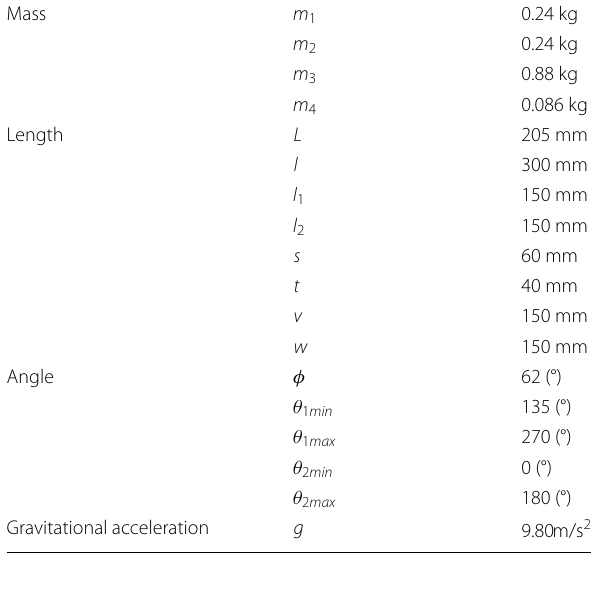
Fig. 9 Range of α and β under landable